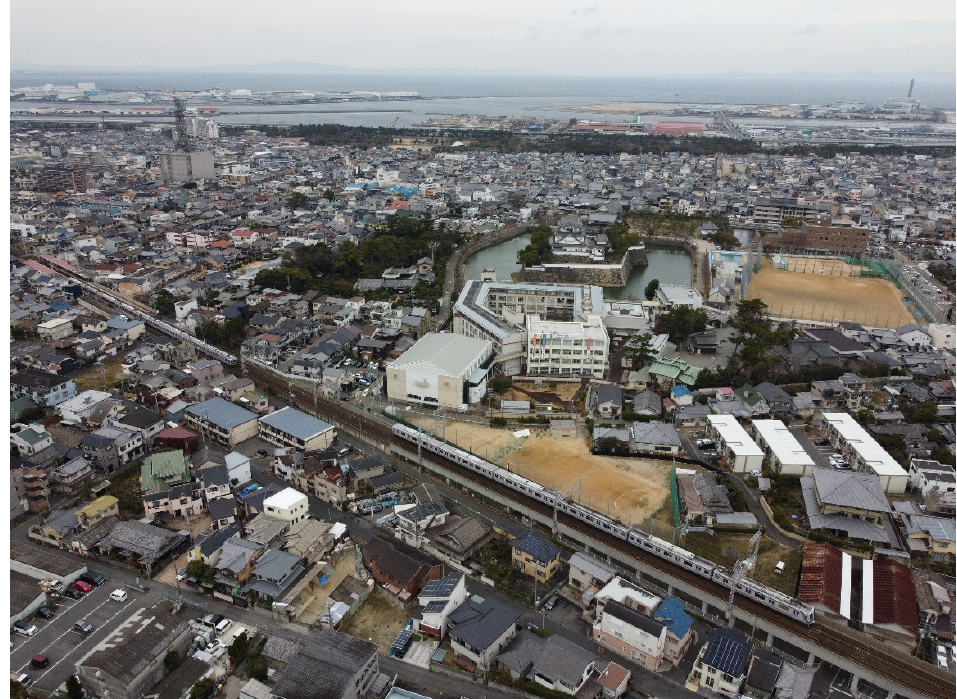
Figure 4. An aerial image of Chikiri Island, our target representative seacoast fill site. Nankai Electric Railway is in the front, and Kishiwada Castle is in the center, showing the original natural land. In the upper right is Chikiri Island on a shallow sea connected by a bridge to the original land area (image acquired by authors on 17 January 2022 using a DJI Mini 2 drone).